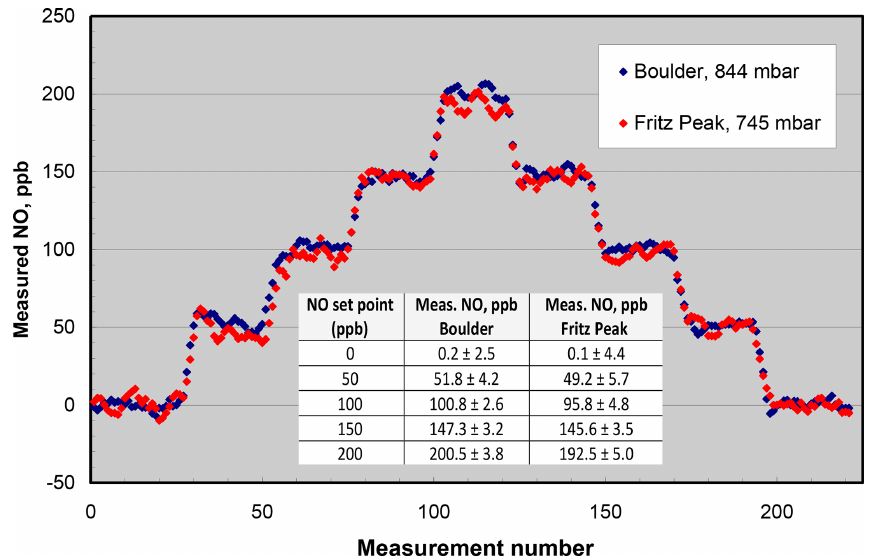
Figure 7. NO measured from the output of a Model 408 NO Calibration Source in Boulder, CO (elevation 1.6km), and Fritz Peak, CO (ele- vation 2.7km). The inset panel gives the averages and standard deviations (1 σ ) at the different NO set points of the calibrator. Measurements were made every 10s.